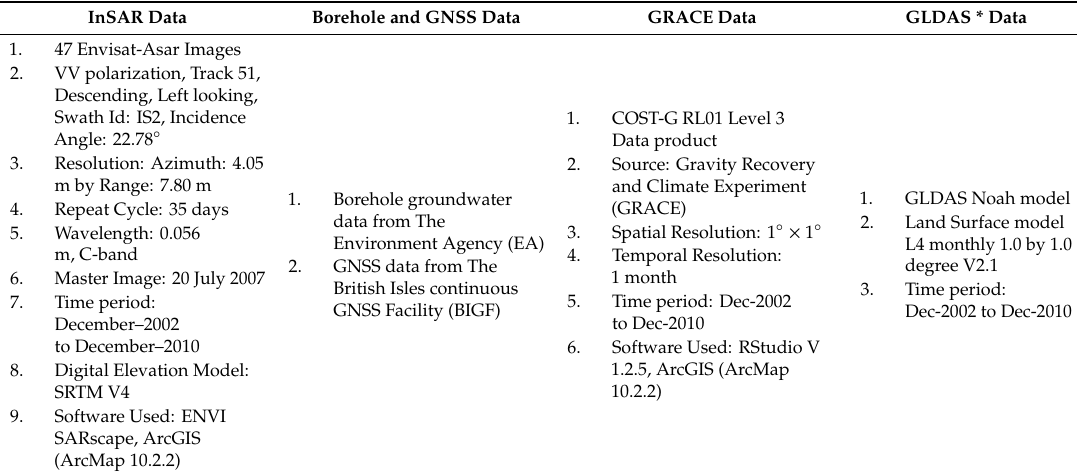
Table 2. Data and software